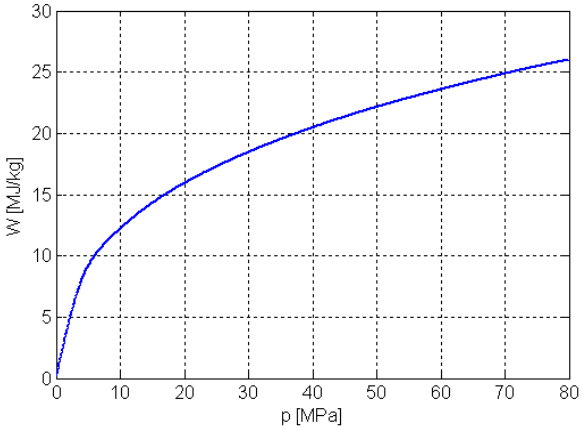
Figure 5. Dependence of work required to compress 1 kg of hydrogen as a function of final pressure [38]. Three benchmarking criteria were defined to compare the options considered.